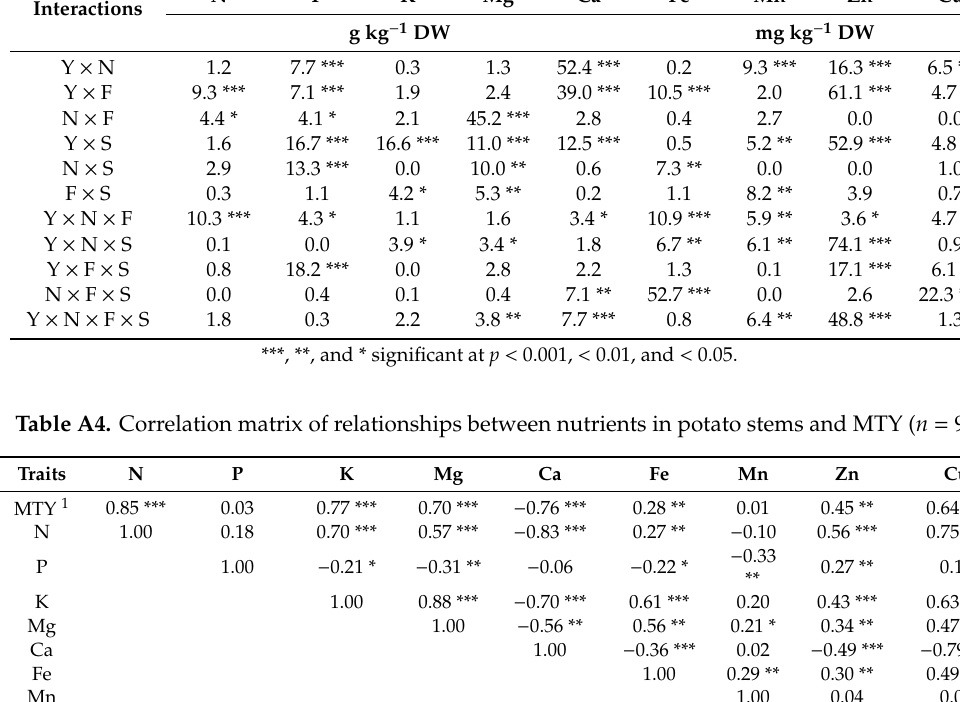
Table A3. Analysis of variance for interactions of factors in potato stems. Interactions